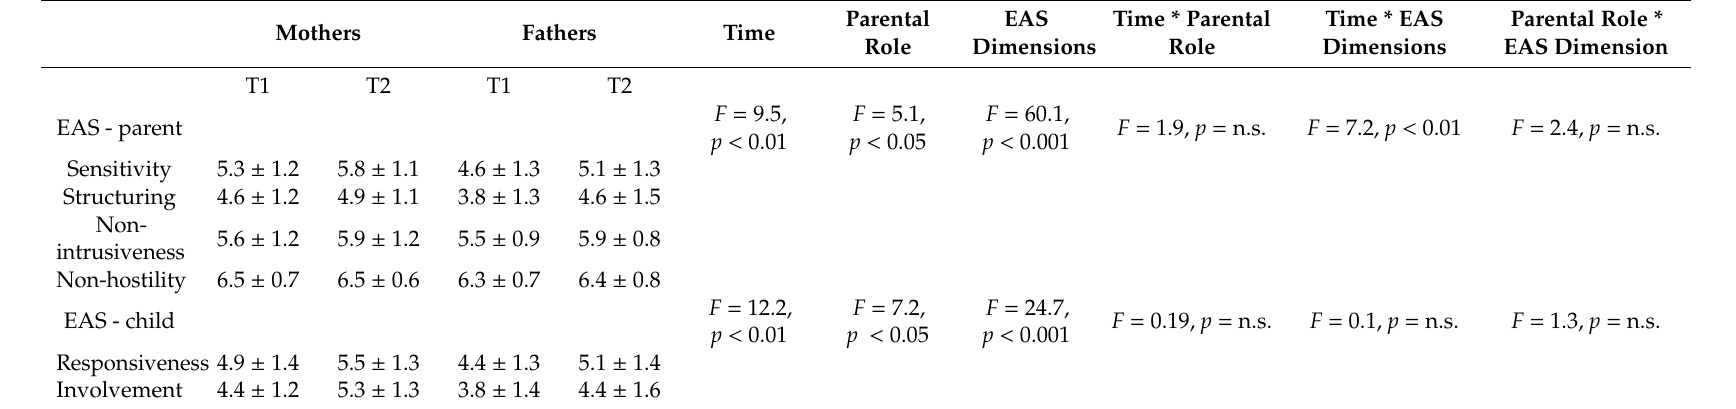
Table 3. Comparisons between mothers and fathers at the two assessments of the parent’s and child’s dimensions of the EAS. Mothers Fathers Time